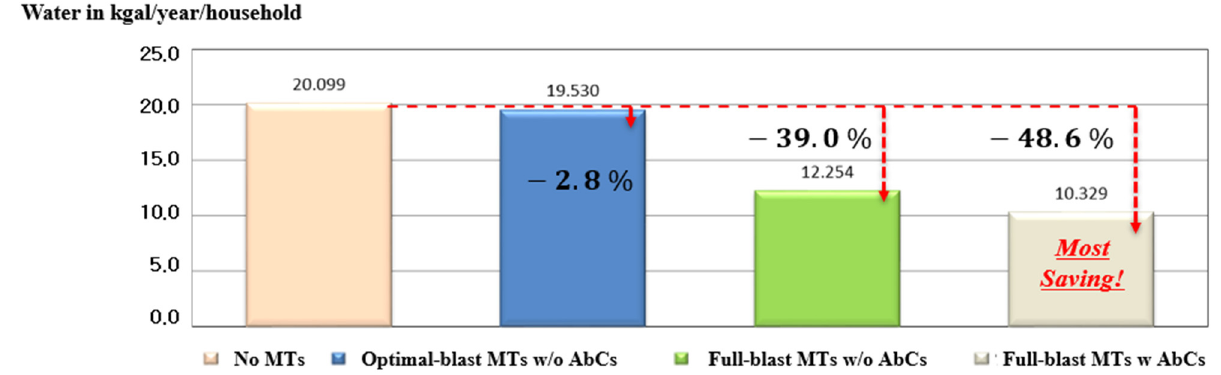
Figure 16. Water emissions savings (scenario 2).